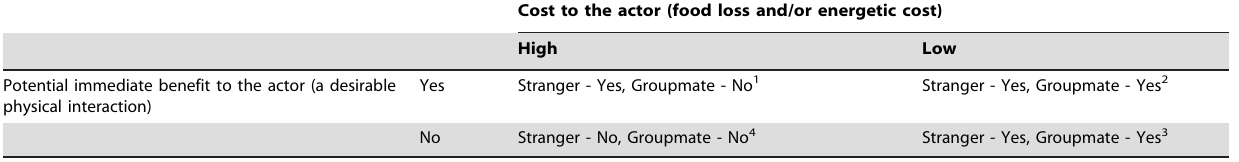
Table 1. Summary of bonobo